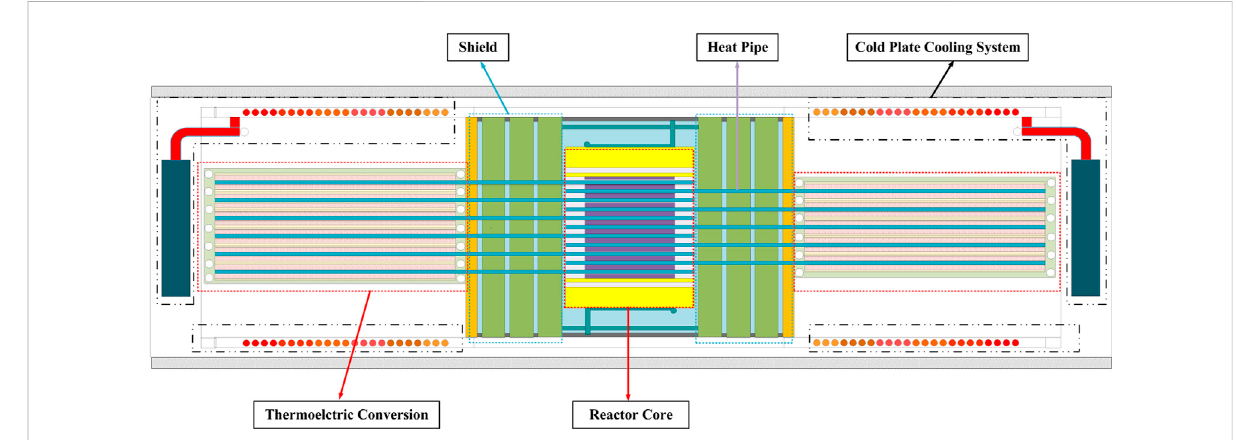
NUSTER-100 structure.